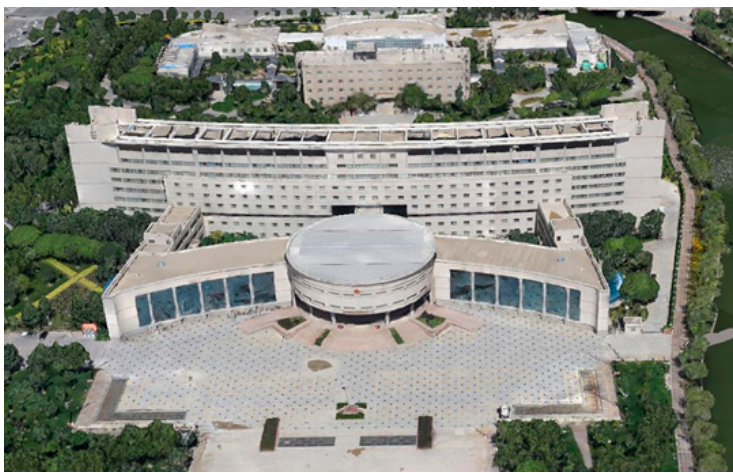
Figure 2. The 3D Modeling (3DM) result and quality of Kuerle city, Xinjiang Uygur Autonomous region of China. Table 1. The efficiency contrast between the 3D Modeling technologies proposed in this paper and the modeling by 3DMAX and SketchUp.